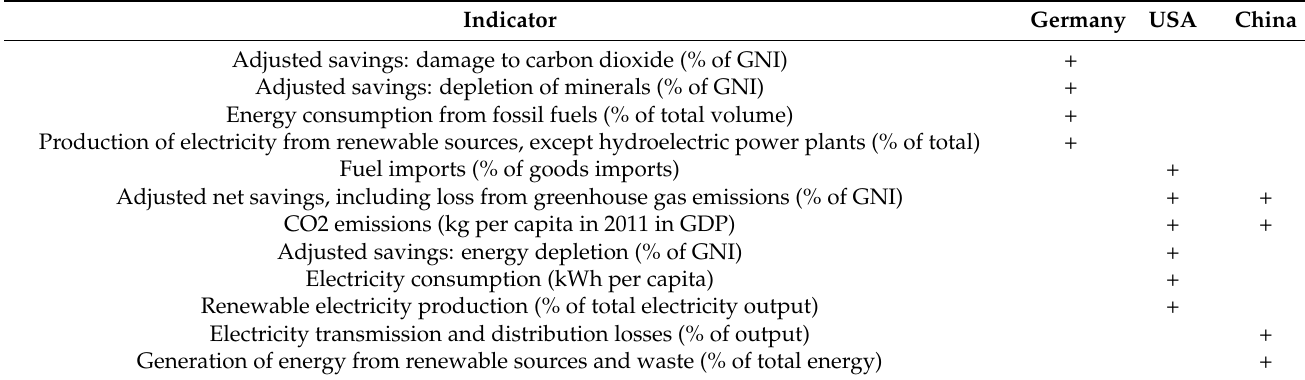
Table 4. Summed up regression results for all analyzed countries.